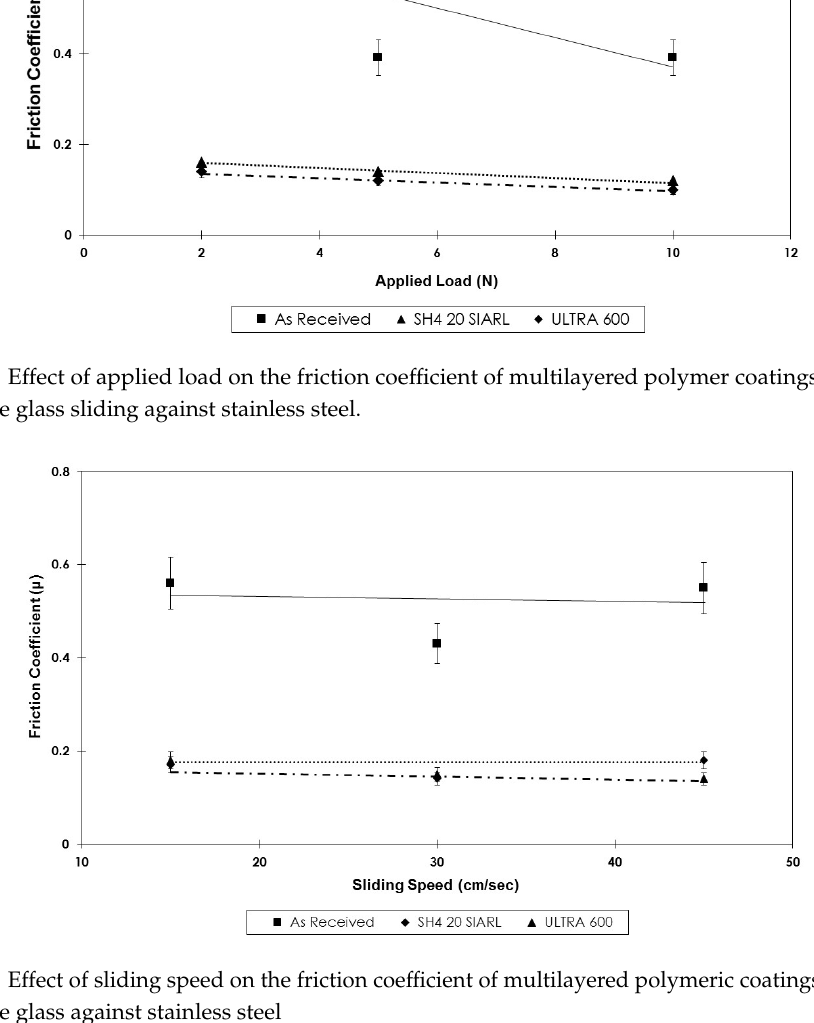
Figure 5. Effect of applied load on the weight loss of multilayered polymer ‐ based coatings on glass and bare soda ‐ lime glass.